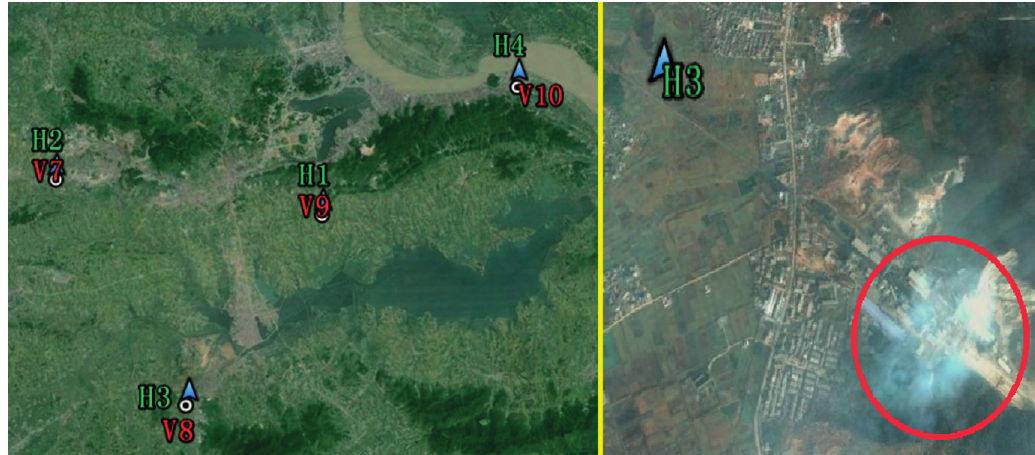
Figure 8. Distributions of four sites in an image of Huangshi and high resolution imagery acquired by satellite in the vicinity of H3. The dimensions of the left and right parts is about 25 km by 35 km and 1.5 km by 1.5 km,